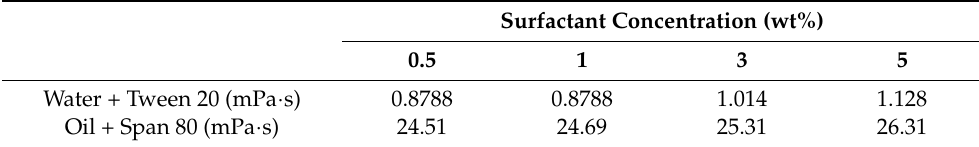
Table 2. Viscosity of surfactant solutions for different concentrations.